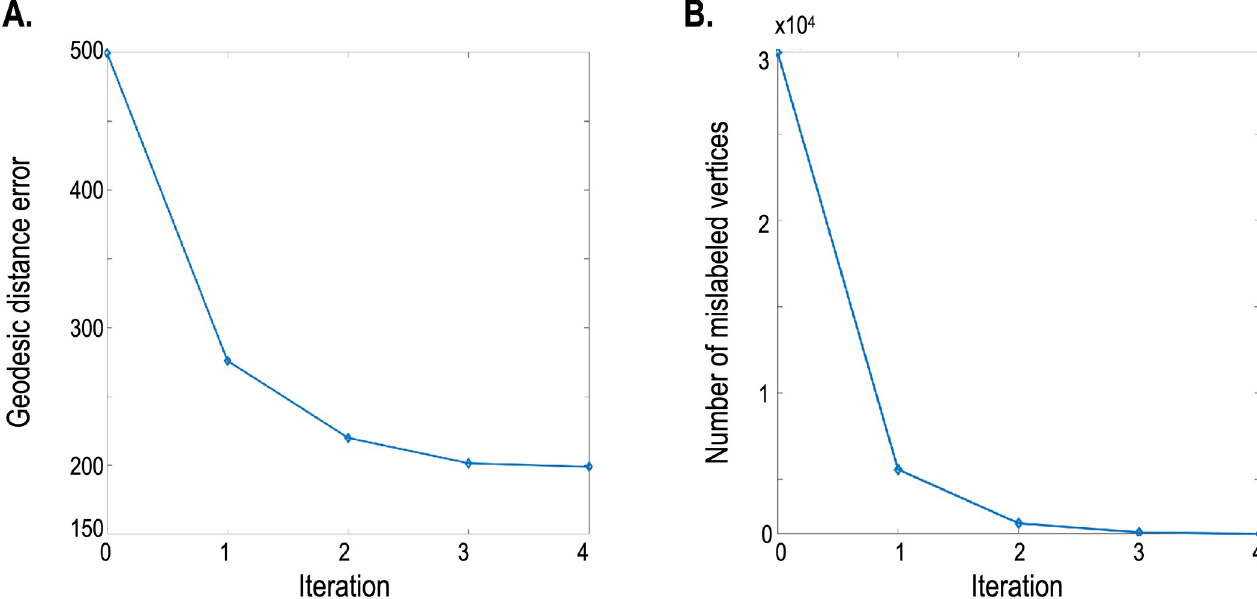
Fig 6. (a) Registration errors defined by the nodes’ geodesic distance are displayed at different iterations. (b) Registration errors defined by the number of wrong-labeled nodes are displayed. The first iteration error was calculated after demons registration only with structural data. In contrast, the registration at the second to the fourth iterations was conducted with both structural and functional properties, weighting functional properties along with the increased